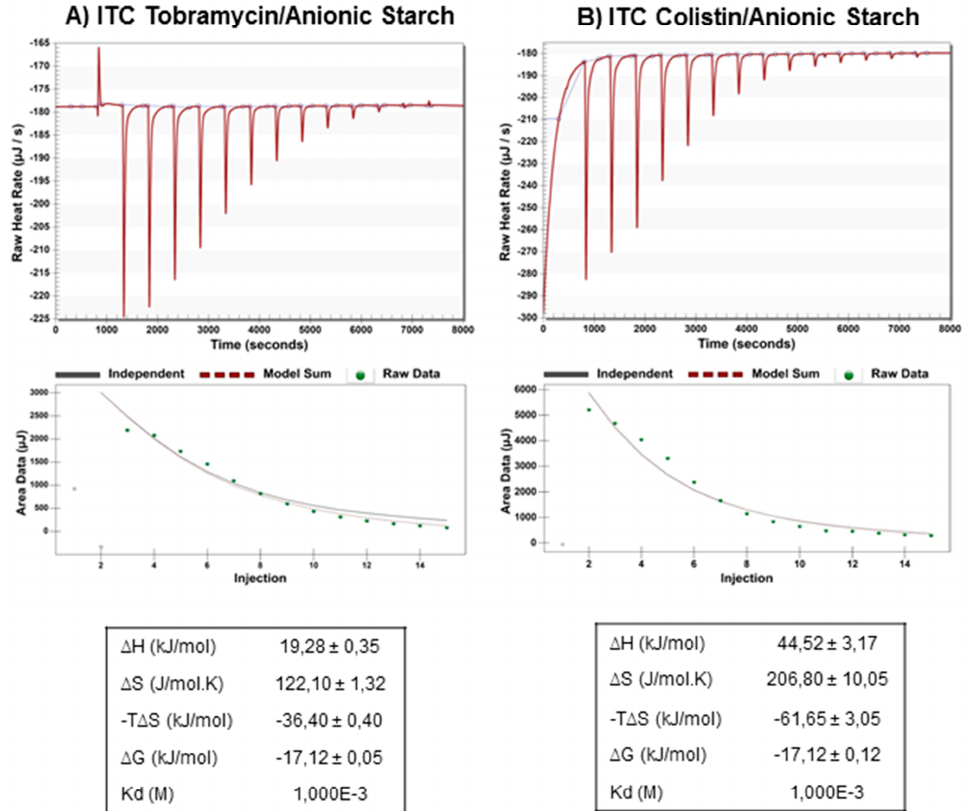
Figure 4. Isothermal titration calorimetry (ITC): ( A ) titration of tobramycin (25 mM) into anionic starch derivative ( M w of >100 kDa) (0.1 mM); and ( B ) titration of colistin (25 mM) into anionic starch derivative ( M w of >100 kDa) (0.1 mM).